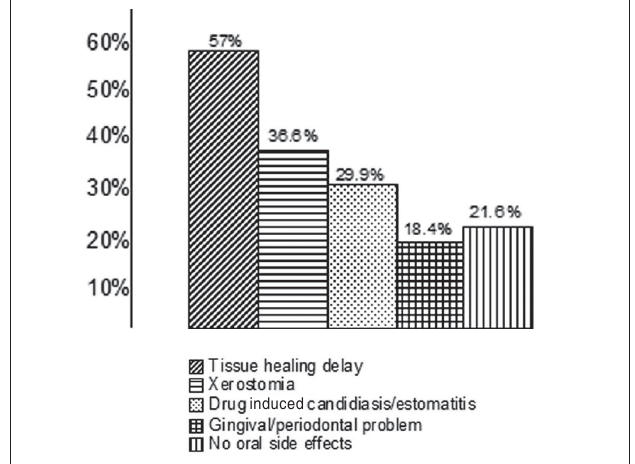
Fig. 1. Percentage of drugs presenting oral side effects reported in prescribing information, medicine guides and textbooks from a total of 8,635 drugs used by the Brazilian elderly population (Adapted from Montenegro et al. 47